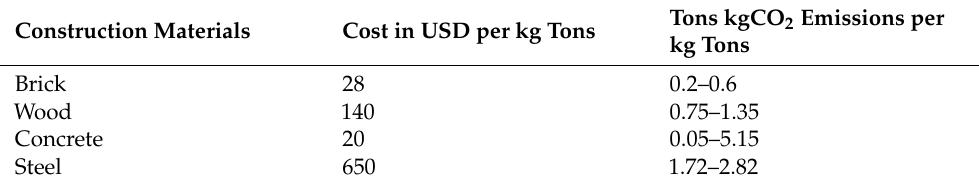
Table A3. Costs and emissions data for considered construction